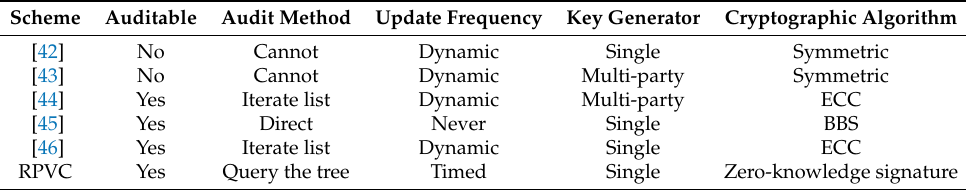
Table 2. Comparison of RPVC with existing